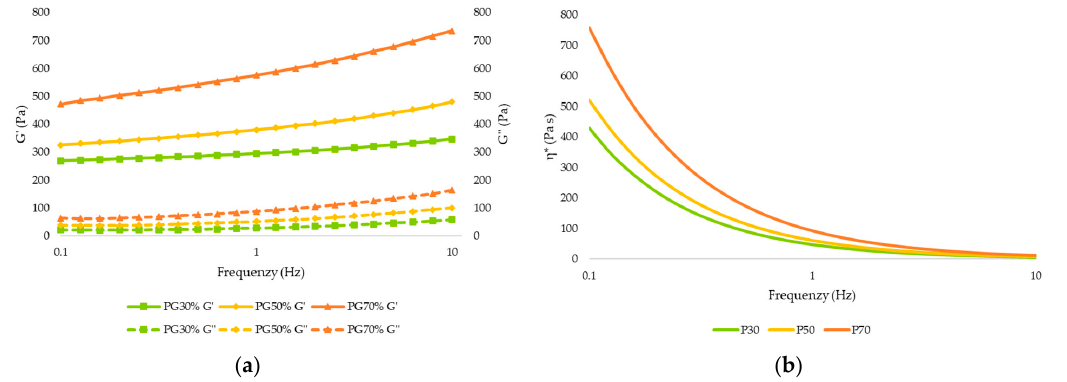
Figure 5. ( a ) Elastic modulus (G ′ ) and viscous modulus (G ″ ). ( b ) Complex viscosity ( η *) of the apricot gel after 3D printing (P30: Printed sample 30% pulp; P50: Printed sample 50% pulp; P70: Printed